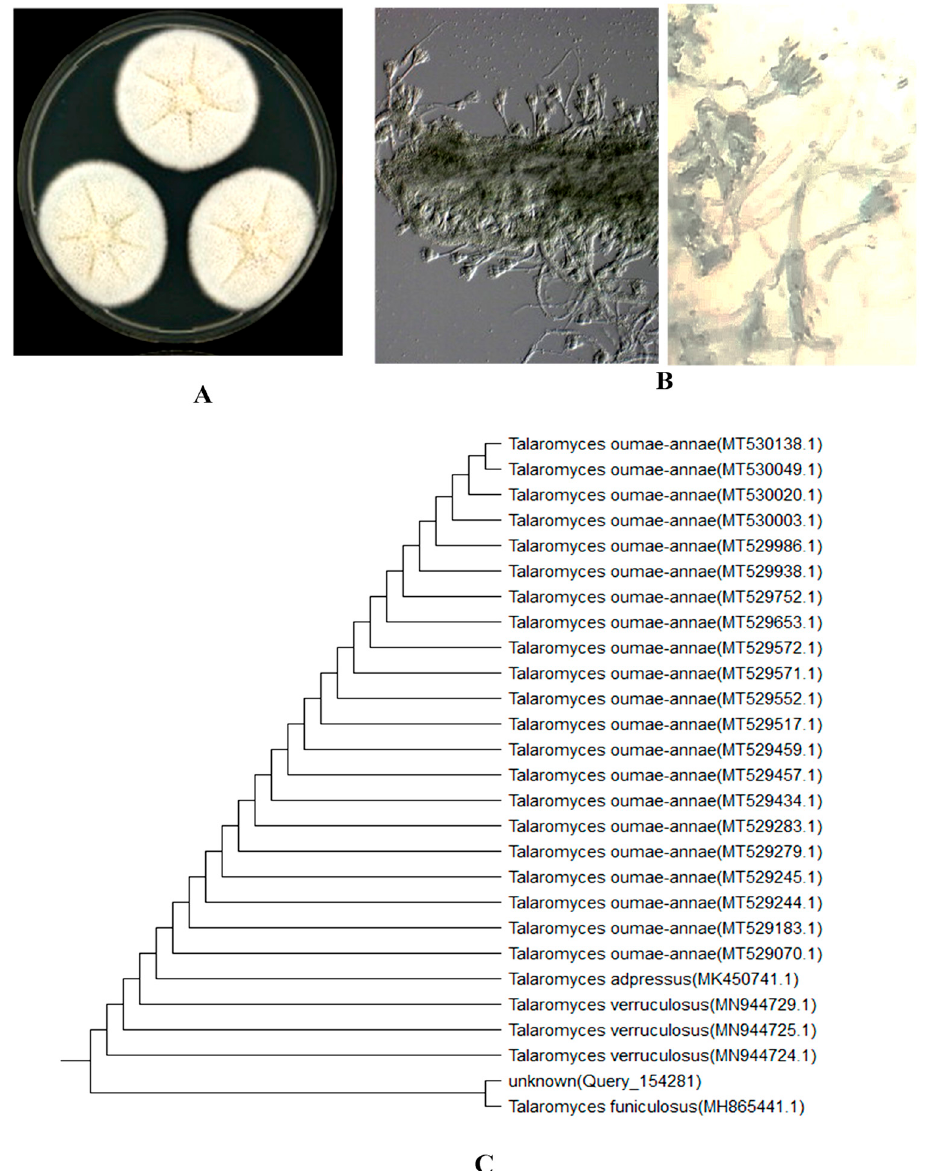
Figure 1. Morphological ( A , B ) and molecular identification ( C ) of T. funiculosus strain CBS 129594.